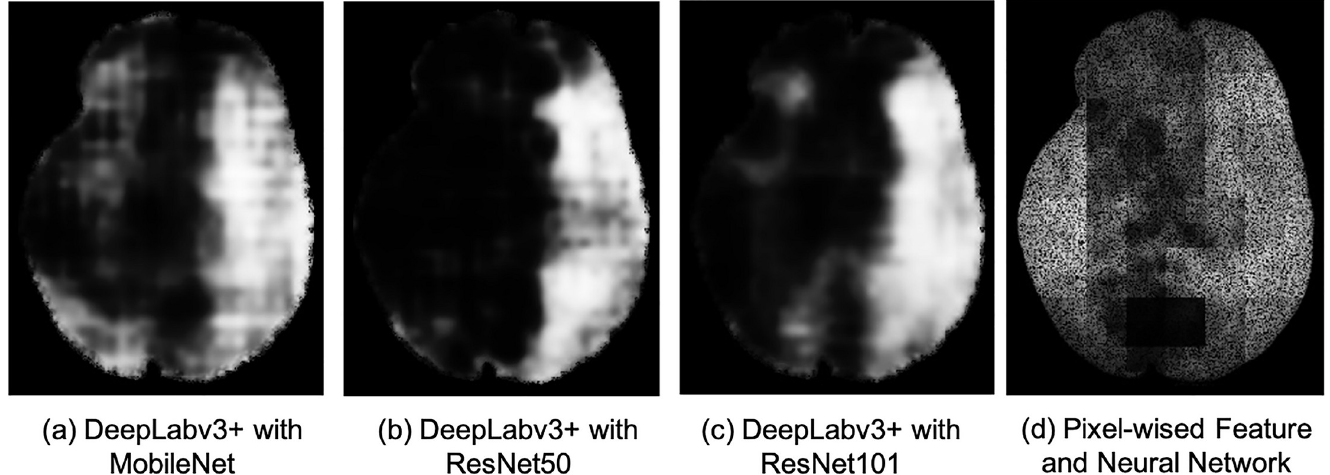
Fig 7. The feature maps. (a) DeepLabv3+ with. (b) DeepLabv3+ with MobileNet ResNet50. (c) DeepLabv3+ with. (d) Pixel-wised Feature ResNet101 and Neural Network.